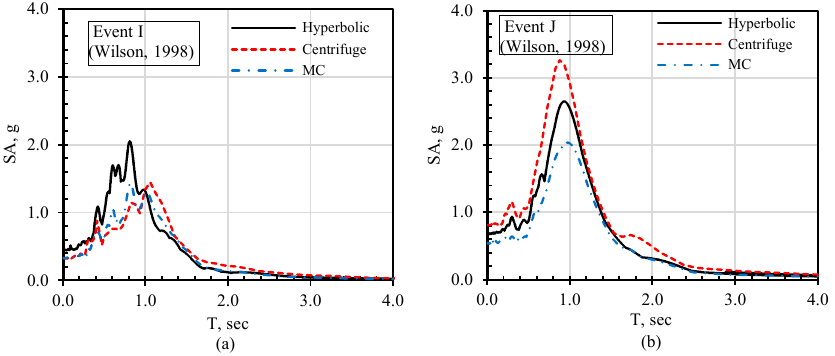
Figure 10. ARS of the structure (D = 5%) for verification analyses (Case 2): ( a ) Event I [31] and ( b ) Event J [31].